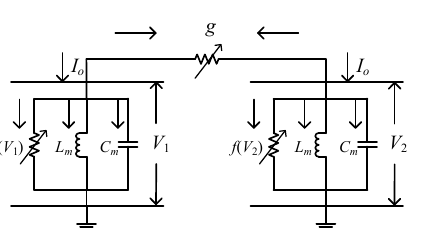
Figure 8. Circuit diagram of two gap-junction-coupled FitzHugh–Nagumo (FHN) neurons. The two gap-junction-coupled FHN neuron model is expressed in Equations (28) and (29).